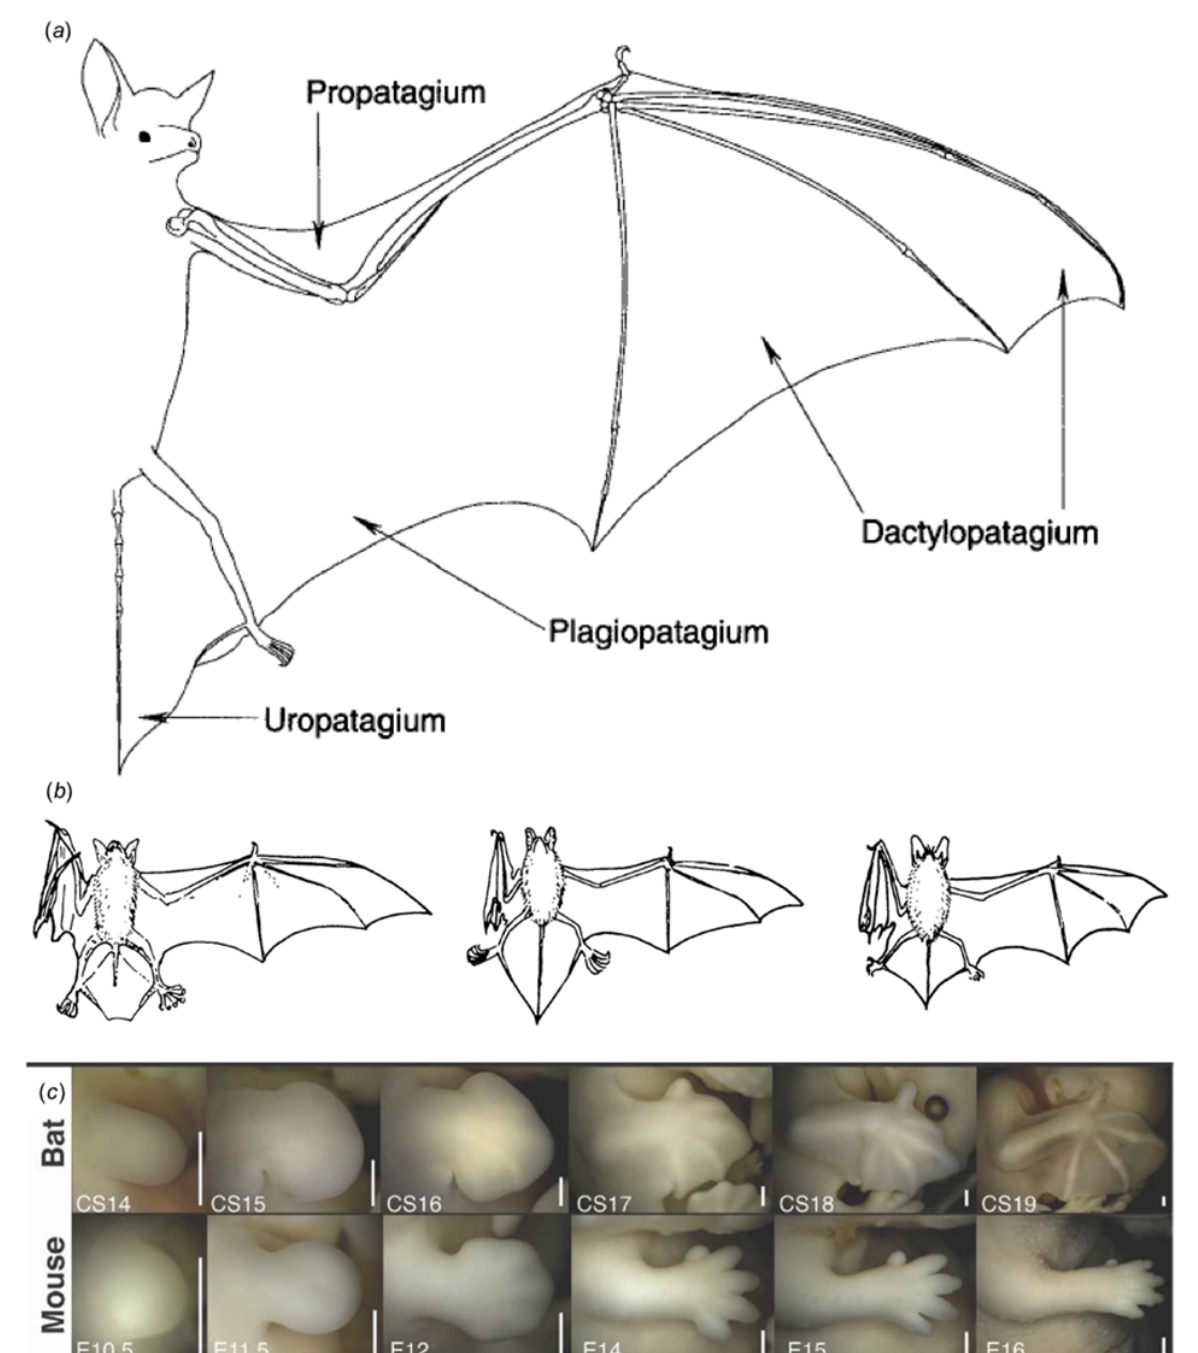
Figure 5 – The anatomy and development of the bat wing (a) Outline of extended forelimb and wing membranes in chiropterans demonstrating the skeleton and membranes (patagia) of the wing (from Swartz et al. , 1996). (b) Examples of variation in size and shape of patagia (from Norberg and Rayner, 1987). (c) Early limb development in bats compared to mice showing early similarities in limb development and divergence in growth and maturation. (from Cretekos et al. ,